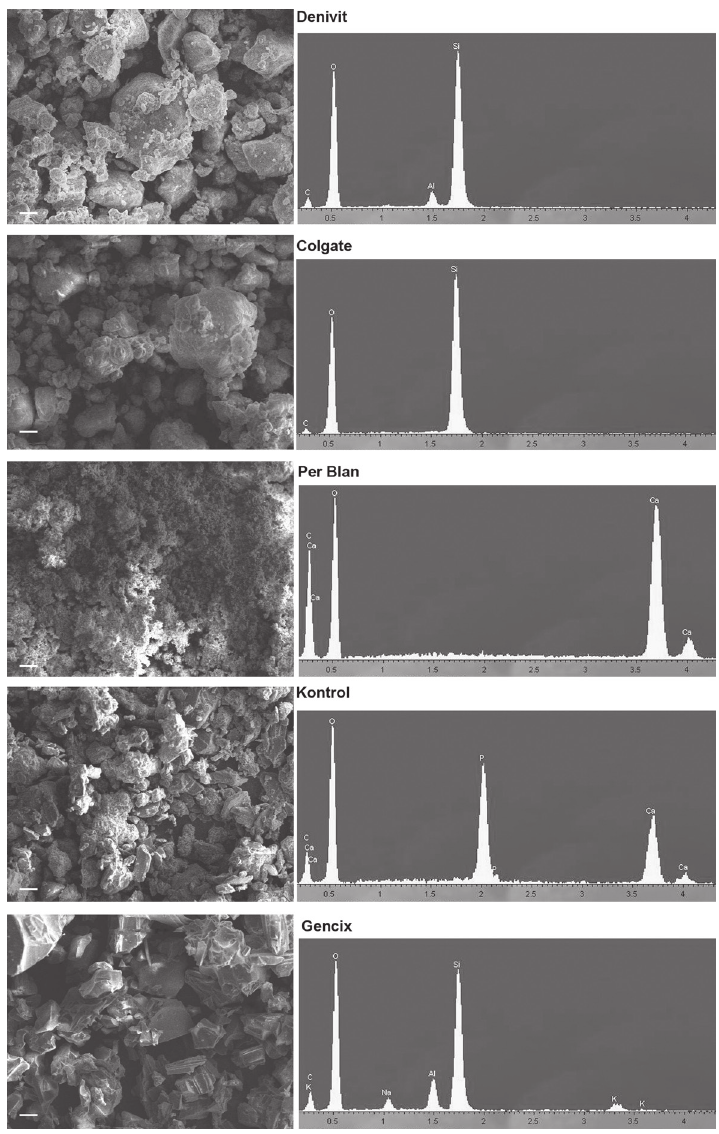
Figure 3- Scanning electron microscopy of the abrasive grains contained in the different types of dentifrices and obtained after extensive washing and centrifugation. The EDX spectrum of each type of particle appears on the right. All images were obtained at the same magnification (500x) and the white bar stands for 10 µm. Note the considerable differences in shape and composition of the abrasive particles contained in the six dentifrices. The NaHCO having being solubilized during the preparation steps, are not